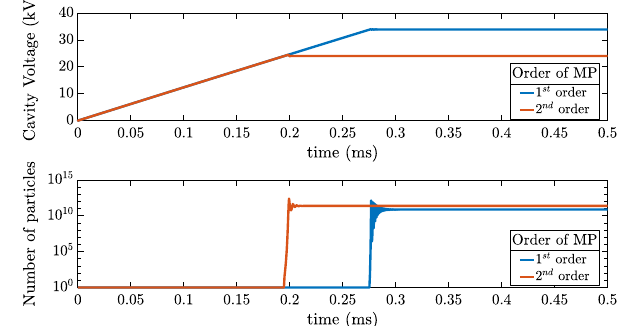
FIG. 19. Cavity voltage and the number of secondary electrons as a function of time: 1st and 2nd order multipacting with the FPC being inserted halfway in, maximal availiable power of 4 kW, and SEY for